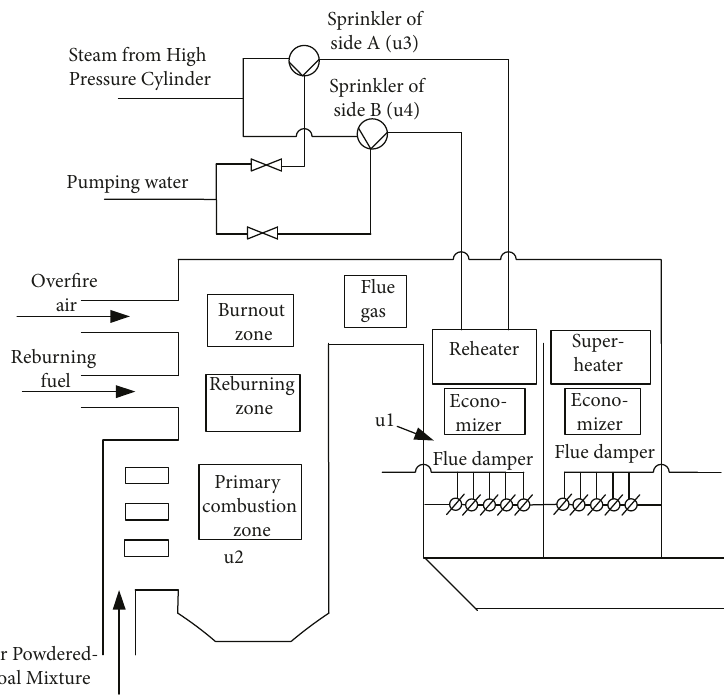
Figure 1: The process diagram of reheat steam temperature control